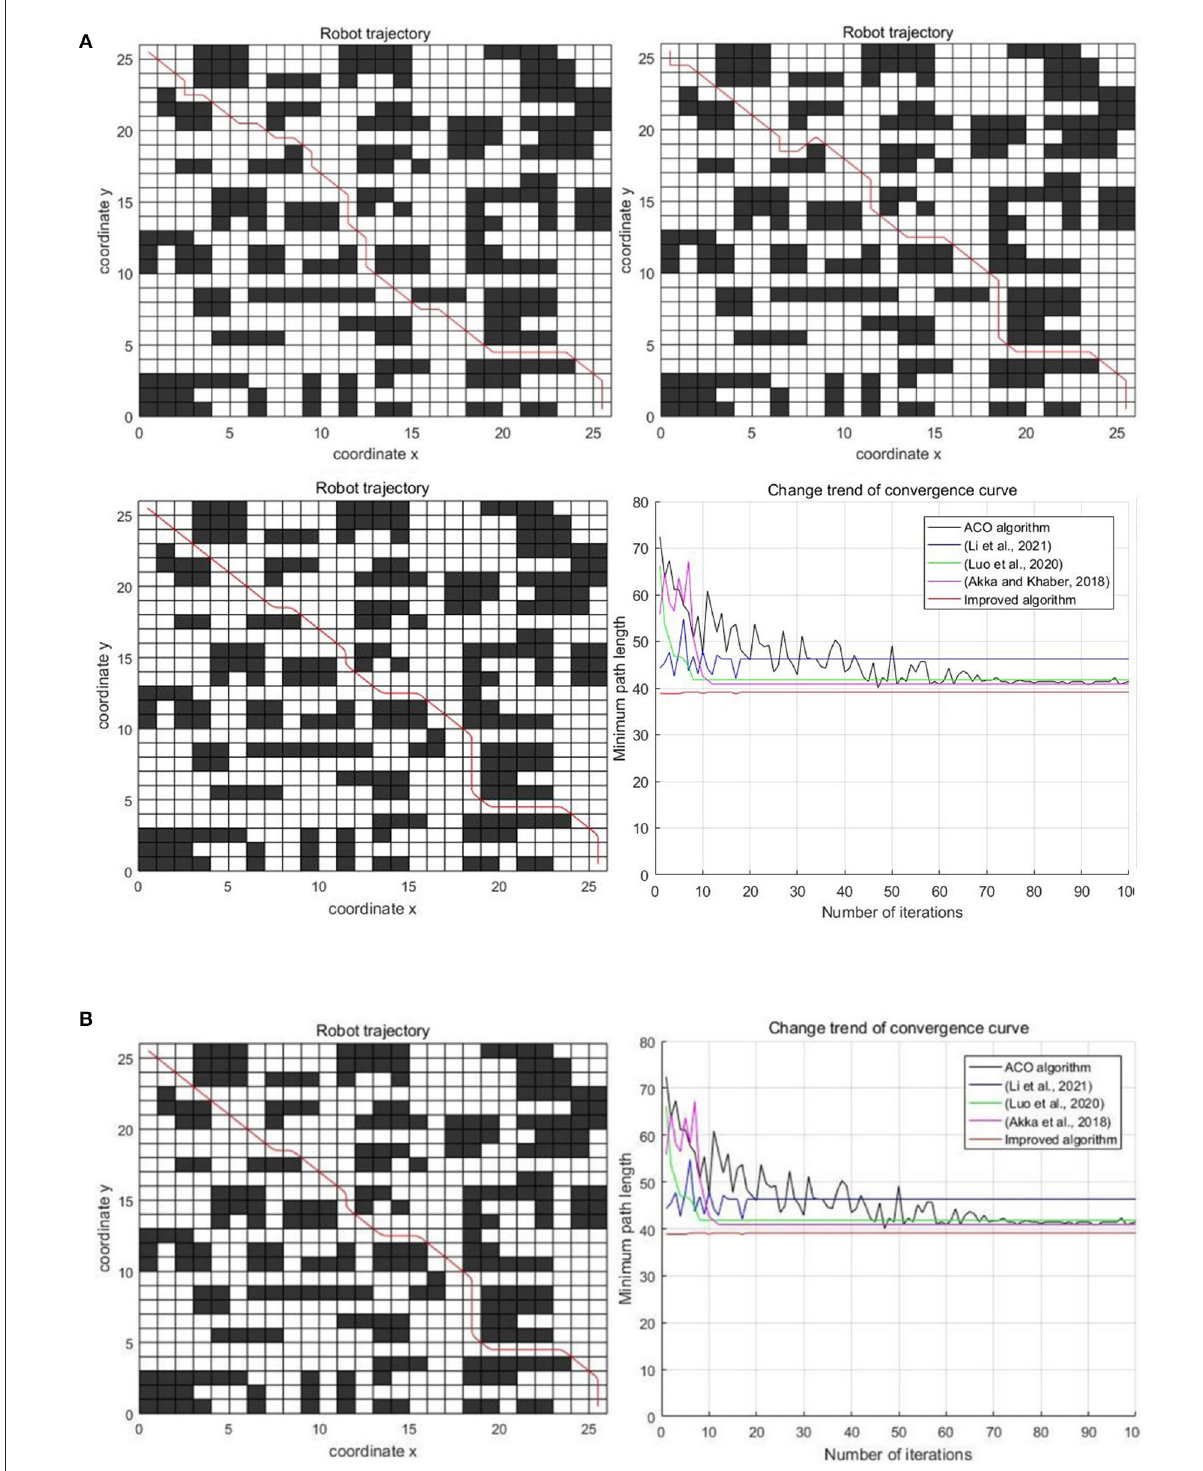
FIGURE12 Experimental results of three algorithms in the decentralized obstacle environment. (A) Classic ant colony algorithm, Luo et al. (2020), Li et al. (2021), and Akka and Khaber (2018). (B) Improved algorithm and comparison of five